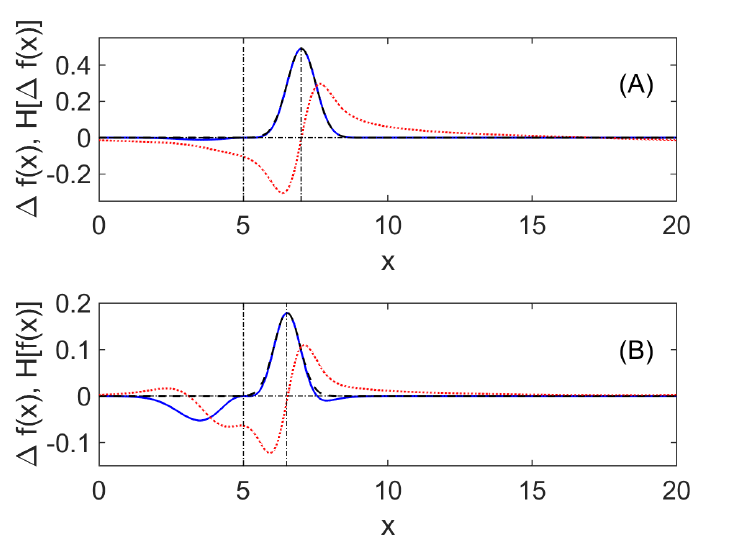
Figure 4. The residuals between the processed signals and their primary found components shown in Figure 3 (solid lines), and the reconstruction of the Gaussian components within these residuals (dashed lines). The subpanels ( A , B ) of this figure correspond to signals presented in subpanels ( B , C ) in Figure 3. Vertical dash-dotted lines indicate exact peak positions for individual components in the initial signal, and the dotted line is the Hilbert transform of the